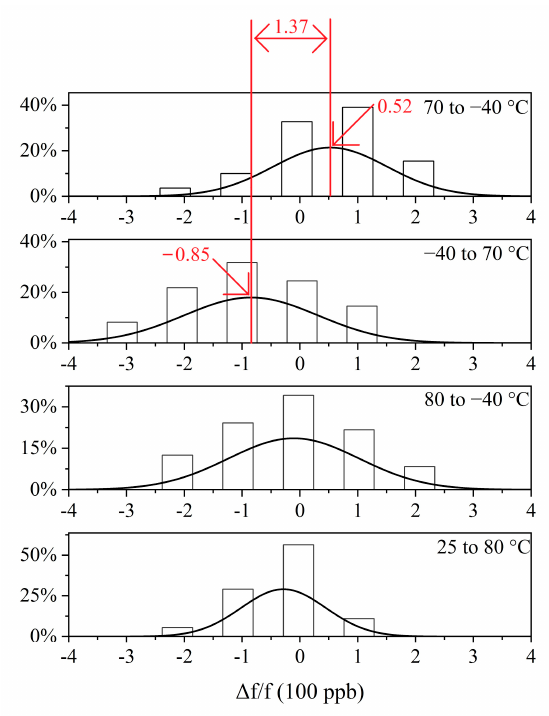
Figure 1. Research methodology process.